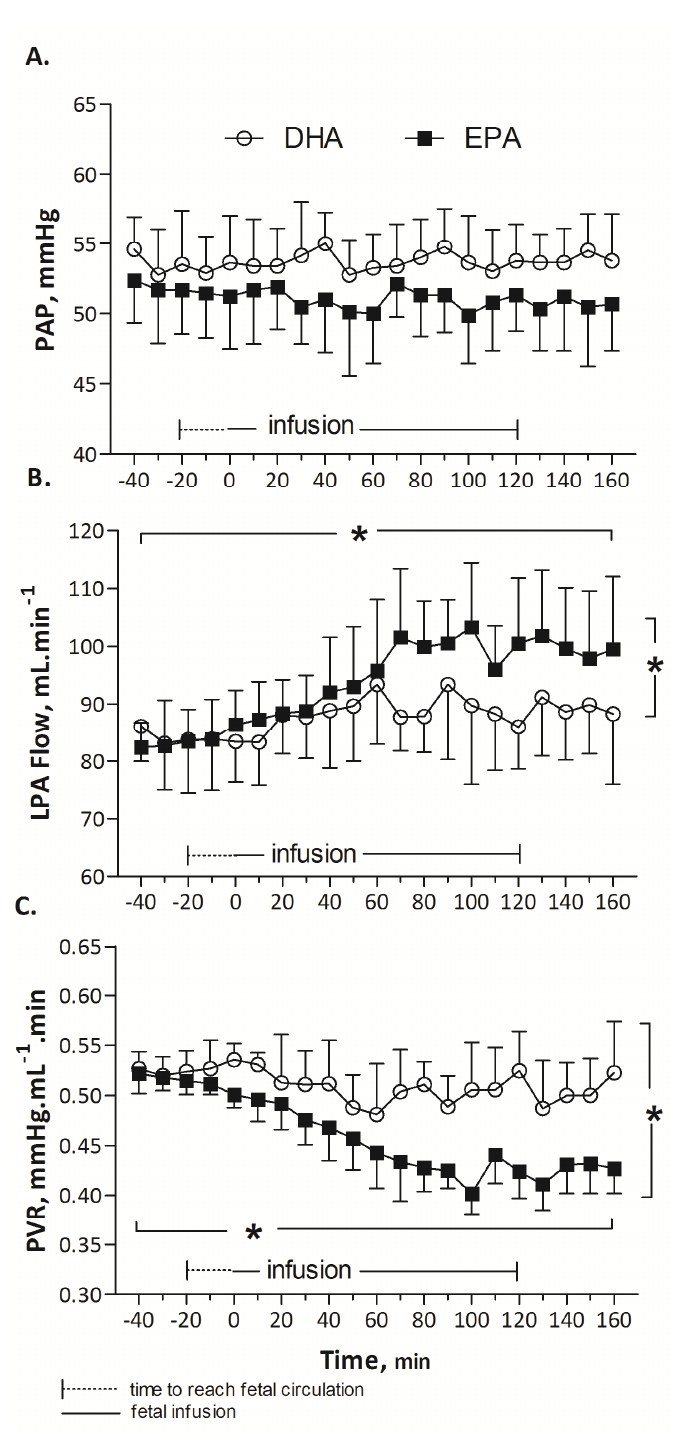
Figure 1. Evolution of pulmonary artery pressure, PAP ( A ), left pulmonary artery blood flow, LPA flow ( B ) and pulmonary vascular resistance, PVR ( C ) in response to infusion of eicosapentaenoic acid (EPA) compared to infusion of docosahexaenoic acid (DHA) (in vivo experiment). EPA or DHA were infused from T ‐ 20 to T120. LPA flow was greater ( B ) and PVR lower ( C ) during EPA than during DHA infusion. Values are means ± SEMs, n = 8 (EPA) or 7 (DHA). * p < 0.001 comparing EPA vs. DHA groups (Two ‐ way ANOVA) and comparing baseline vs. EPA infusion (one ‐ way ANOVA).